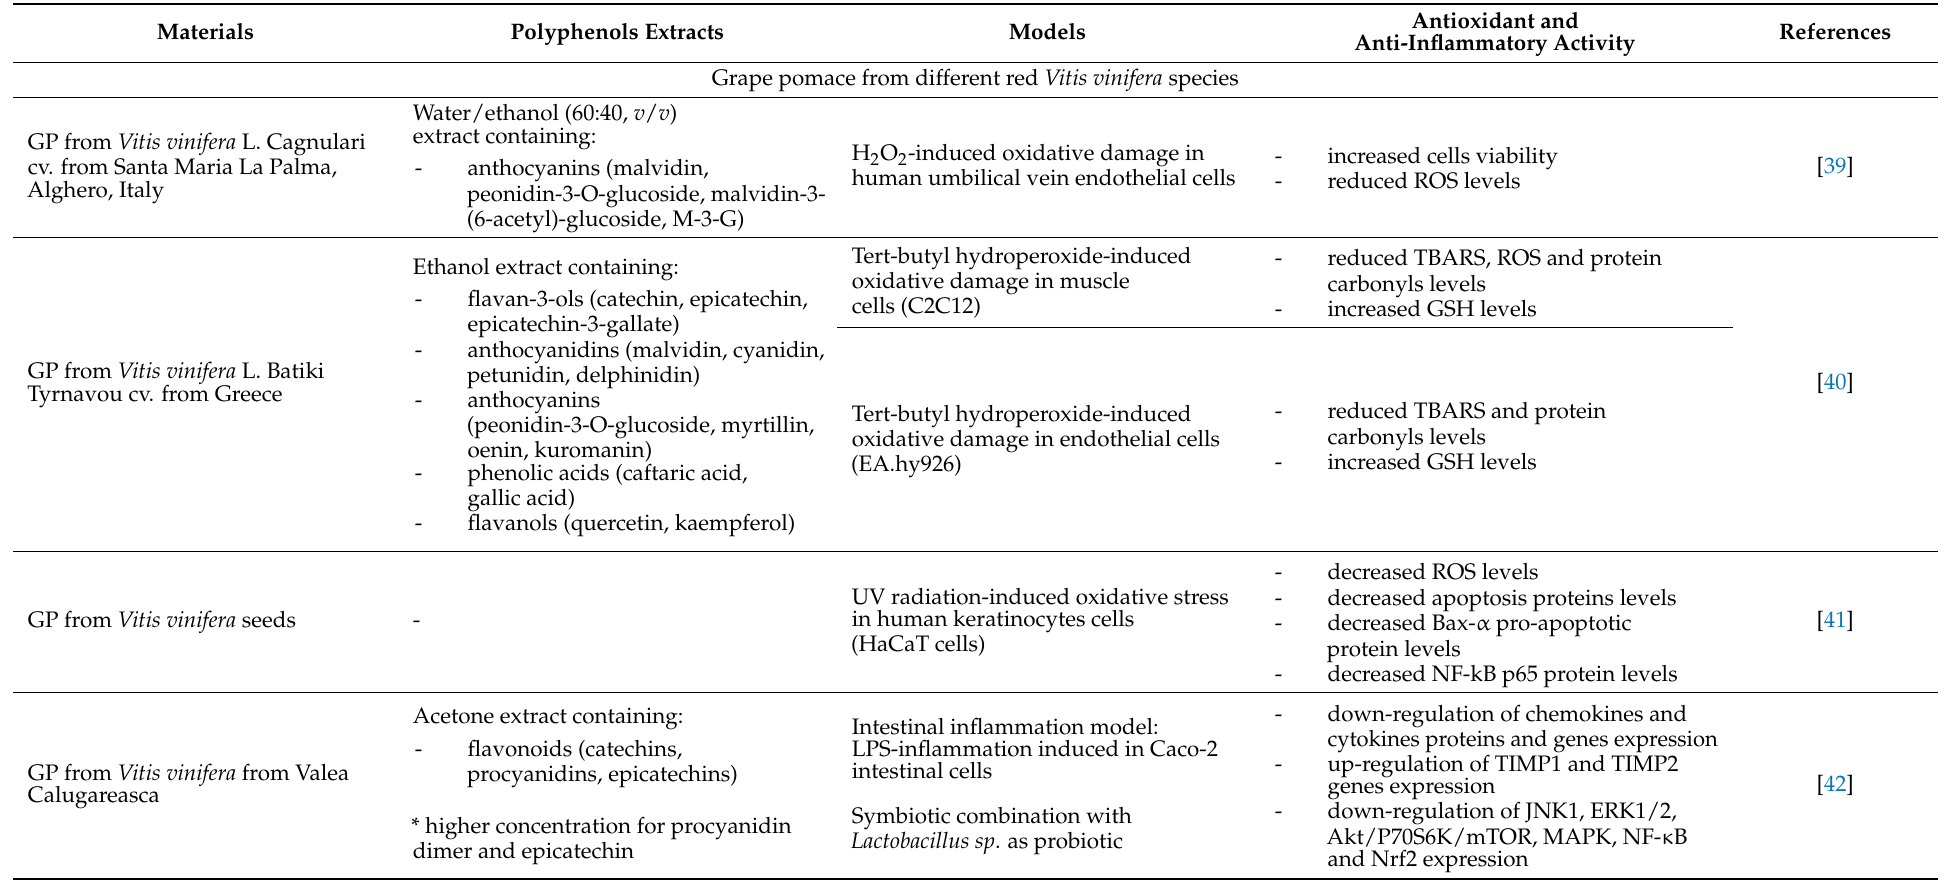
Table 2. In vitro antioxidant and anti-inflammatory activity of grape pomace polyphenols